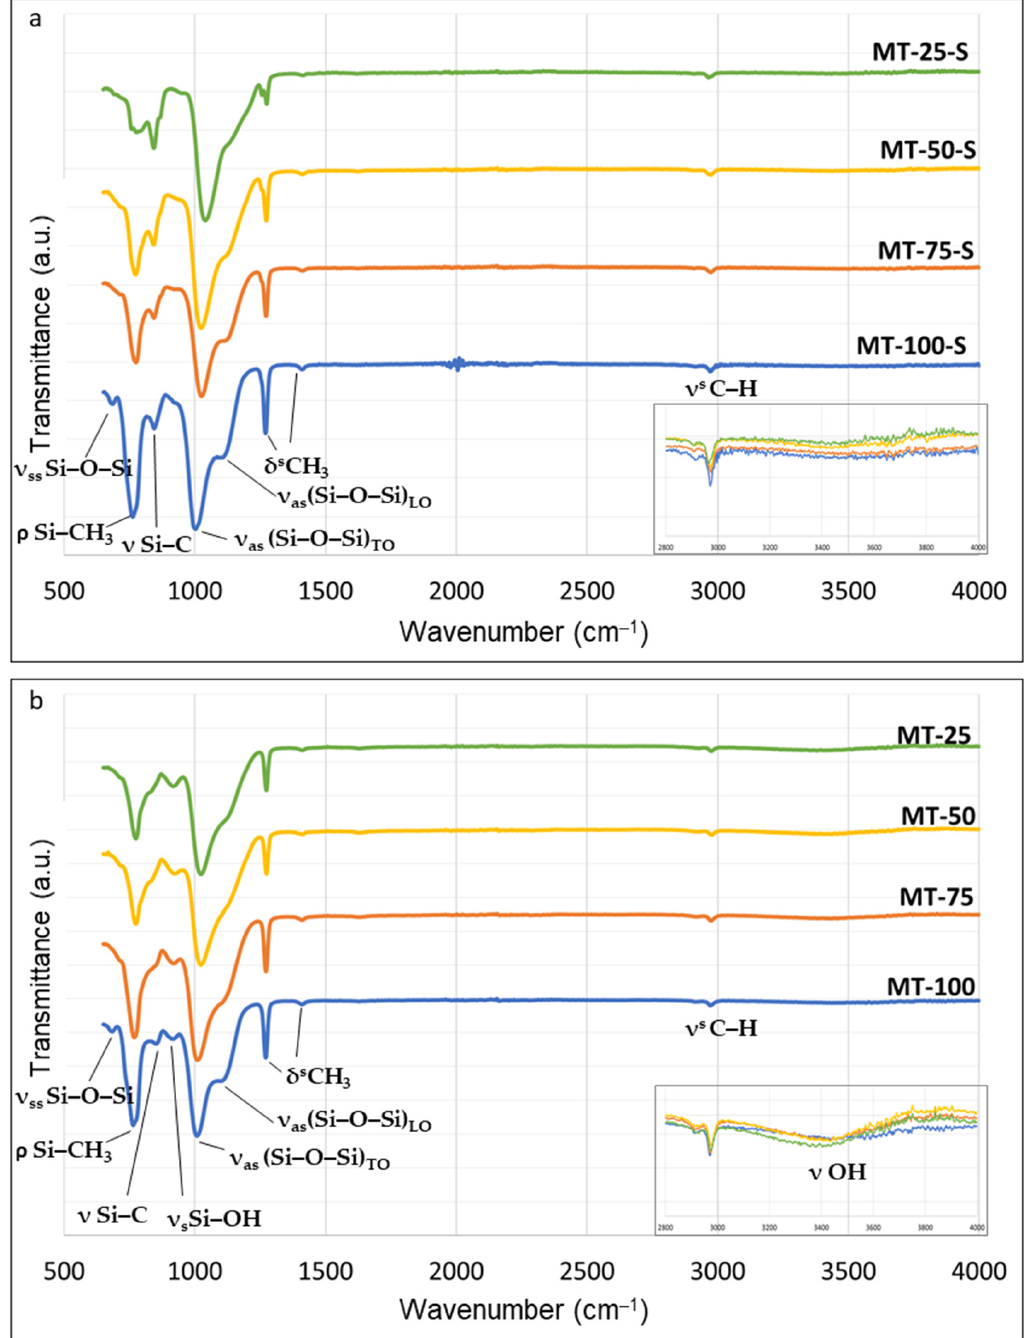
Figure 1. The FTIR spectrum of the ( a ) silylated and ( b ) non ‐ silylated silica xerogels.